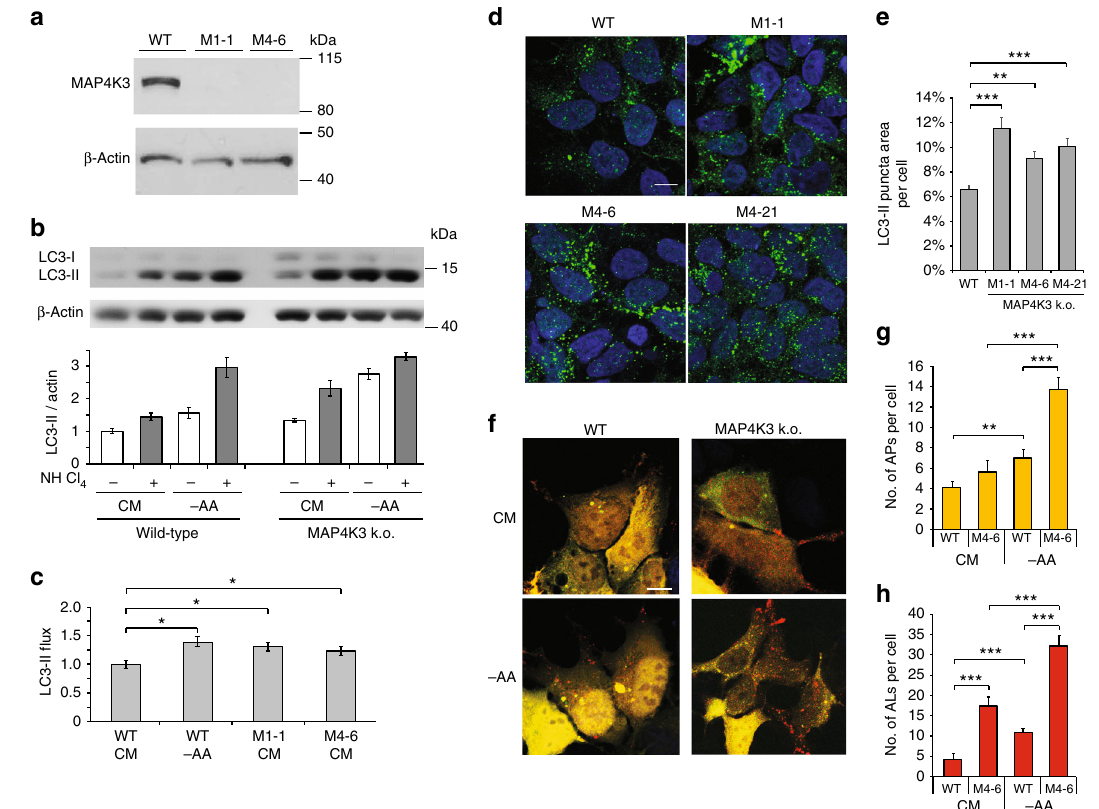
Fig. 1 Knockout of MAP4K3 promotes autophagy induction and fl ux. a Validation of MAP4K3 knockout (k.o.) cell lines. Wild-type (WT) and HEK293A cells gene-edited with either of two different sgRNAs (M1 and M4) were lysed, and protein lysates were immunoblotted for MAP4K3. Immunoblotting of β -actin served as a loading control. b , c Knockout of MAP4K3 promotes autophagy fl ux. WT HEK293A cells, M1-1 MAP4K3 k.o. cells, and M4-6 MAP4K3 k.o. cells (not shown) were cultured in complete media (CM) or subjected to amino acid starvation ( – AA), and remained untreated or were treated with ammonium chloride. Protein lysates were immunoblotted for LC3 and β -actin, which served as a loading control b . The ratio of LC3-II:actin was determined by densitometry using ImageJ and normalized to WT CM, which was arbitrarily set to 1 c . One-way ANOVA with post-hoc Tukey ’ s test; * P < 0.05. d , e Knockout of MAP4K3 promotes autophagy induction. LC-3 immunostaining of WT HEK293A cells and three different MAP4K3 k.o. cell lines, all cultured in CM d . Quanti fi cation of LC3 puncta area per cell area was determined using ImageJ. n > 100 cells per genotype. One-way ANOVA with post-hoc Tukey ’ s test; ** P < 0.01, *** P < 0.001. f – h Knockout of MAP4K3 promotes autophagy fl ux. WT HEK293A cells and MAP4K3 k.o. cells were cultured in CM or amino acid starved, and were transfected with a GFP-mCherry-LC3 expression construct ( f ). Note the predominance of red puncta indicative of autolysosomes in MAP4K3 k.o. cells. Quanti fi cation of autophagosome number per cell was determined by counting yellow puncta GFP-mCherry-LC3-expressing cell ( g ). Quanti fi cation of autolysosome number per cell was determined by counting red puncta/GFP-mCherry-LC3-expressing cell ( h ). n > 50 cells per condition. One-way ANOVA with post-hoc Tukey ’ test; ** P < 0.01, *** P < 0.001. All experiments were performed in triplicate. Error bars = SEM. Scale bars = 10 μ